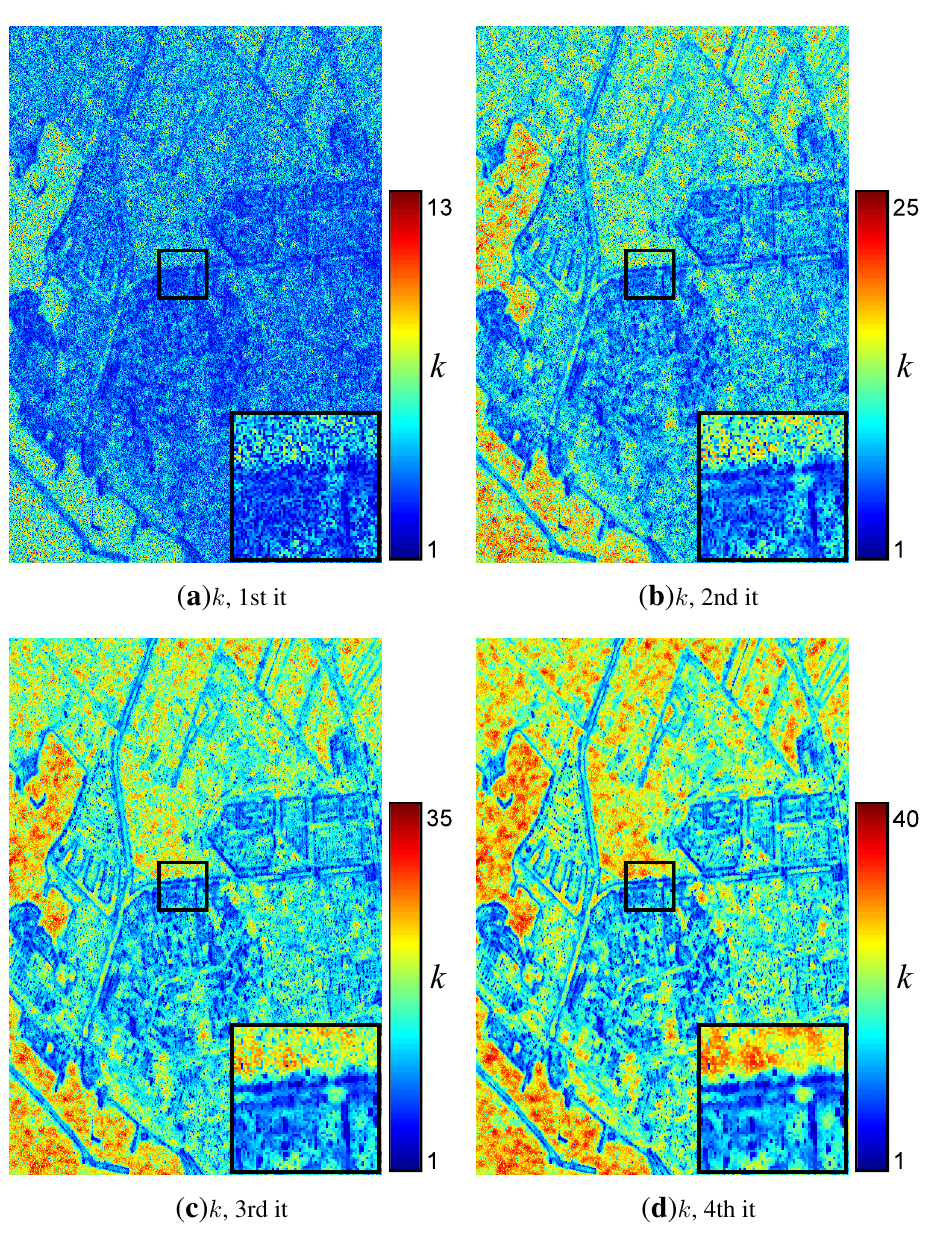
Figure 5. Evolution of the k parameter, corresponding to the number of averaged pixels, among the different iterations of the weight refinement scheme presented in Figure 1; ( a ) 1st, ( b ) 2nd, ( c ) 3rd and ( d ) 4th iteration. The k parameter of the final iteration corresponds to Figure